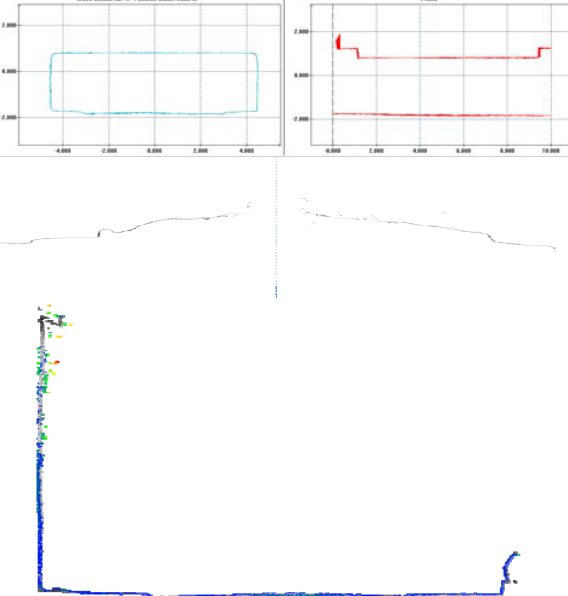
Fig. 16: Profiles of tunnel, traffic circle, road and